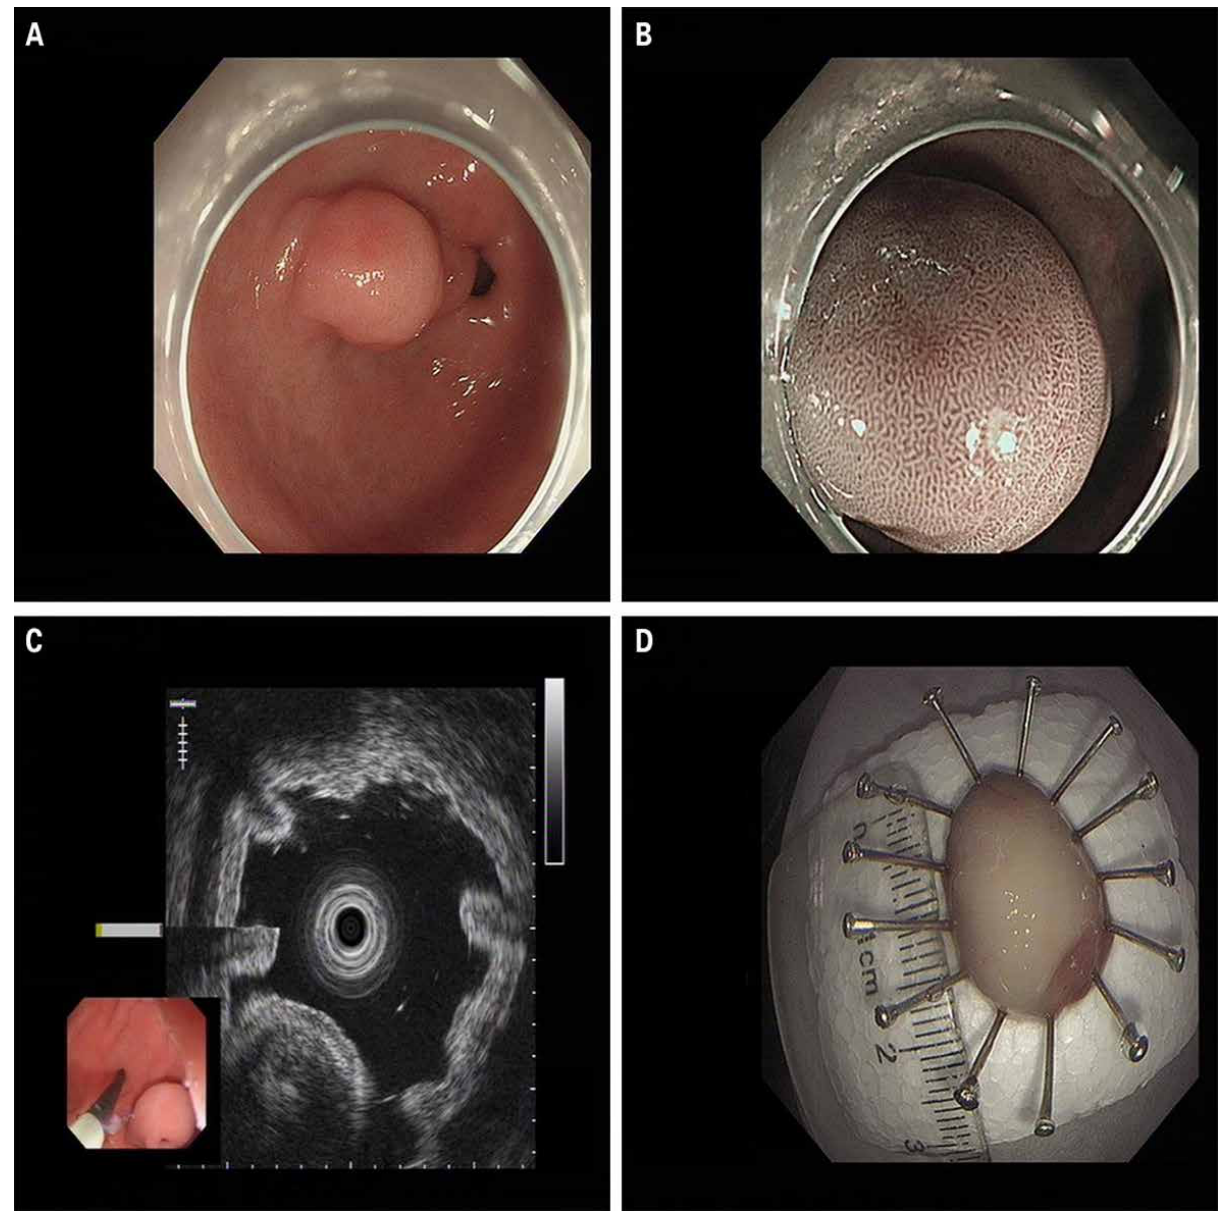
A. A submucosal protuberant lesion in the gastric antrum with well-defined borders. B. Surface microstructure and microvascular patterns were regular. Its surface appearance was similar to that of the surrounding normal tissue. There seemed to be a slight depression in the center of the lesion. The glands were slightly dense. C. A hypoechoic tumor with slightly heterogeneous internal echoes originating from the submucosal area located at the gastric antrum. D. Pathological tissue obtained by ESD, which was a yellow oval tissue measuring 1.3*1.0 cm. ESD= Endoscopic submucosal